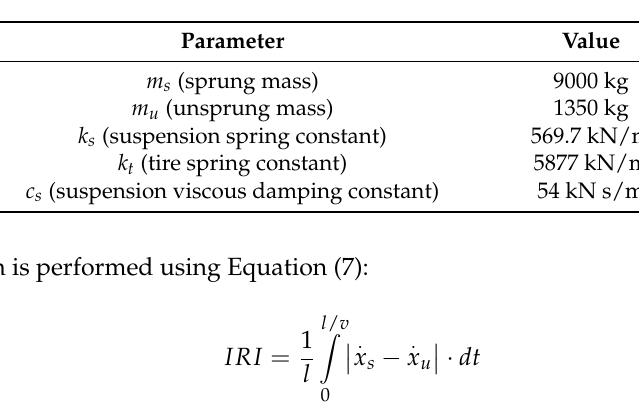
Table 4. Golden-car mechanical parameters for the IRI quarter-car model.